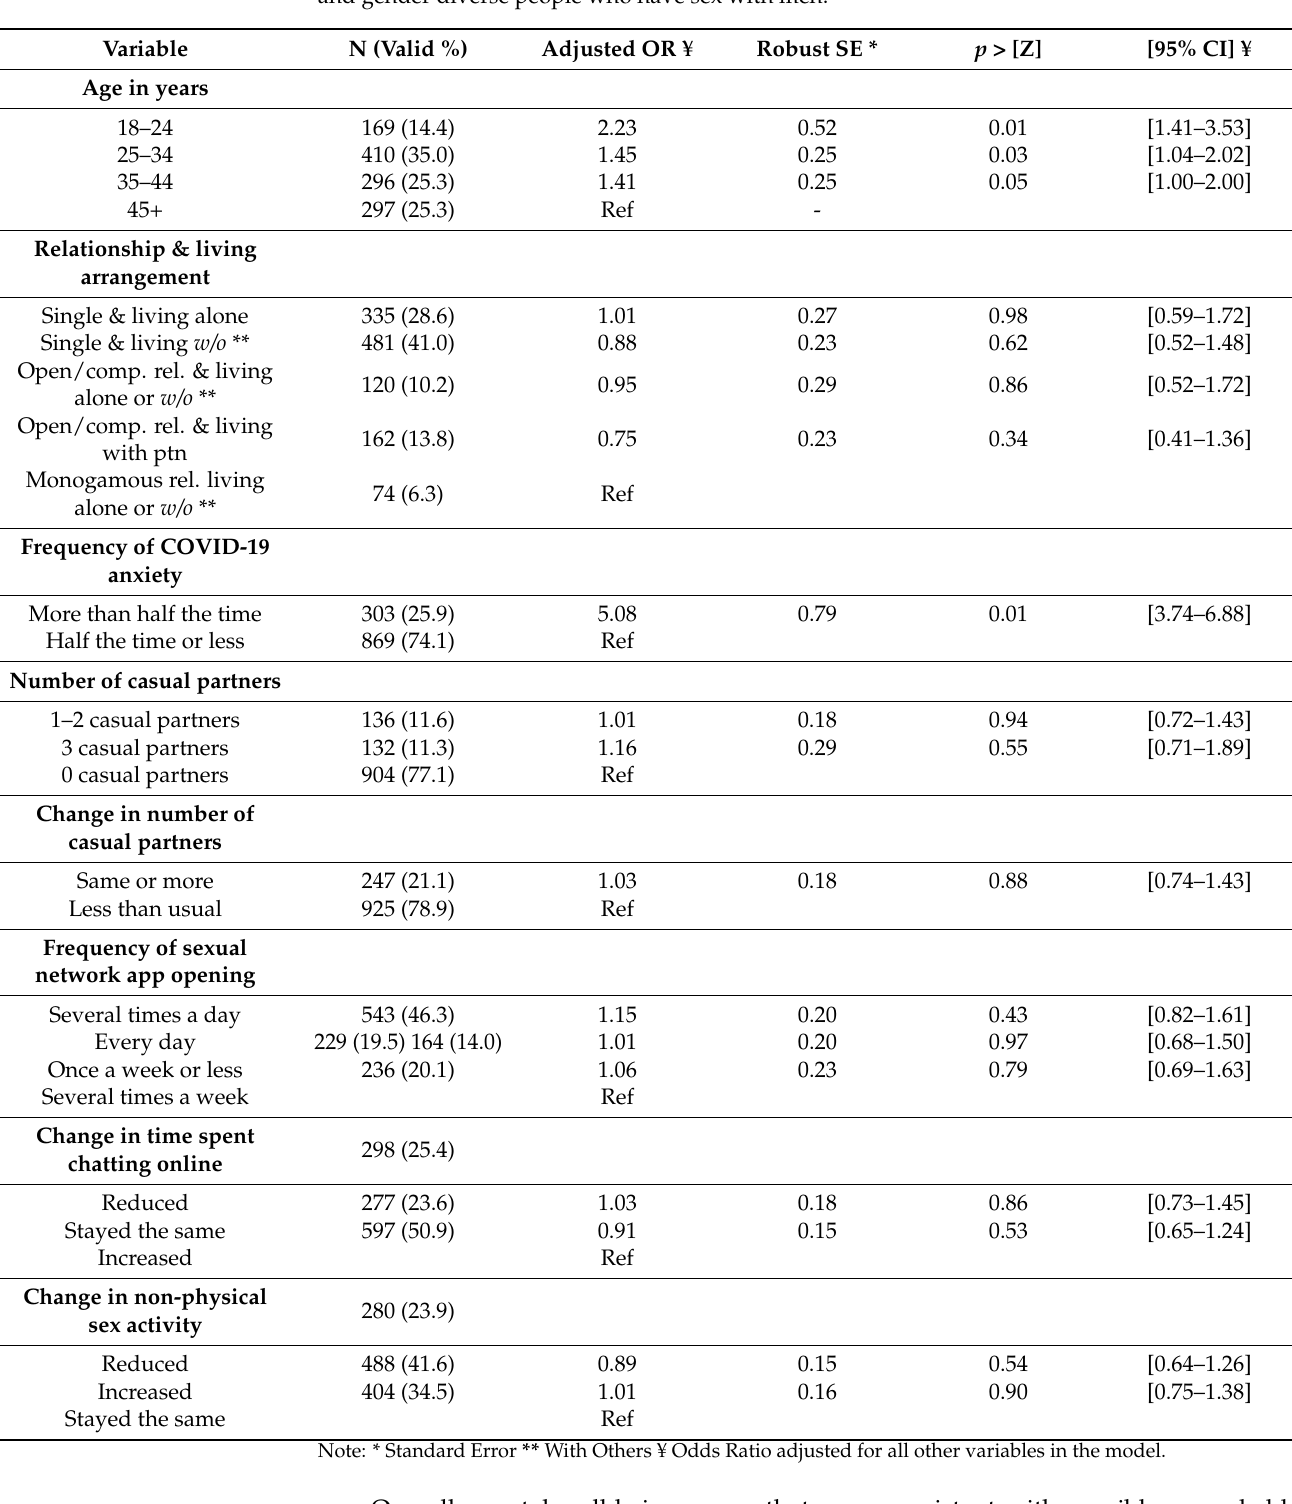
Table 1. Predictors of low mental well-being during the UK lockdown (March–April 2020) in men and gender diverse people who have sex with